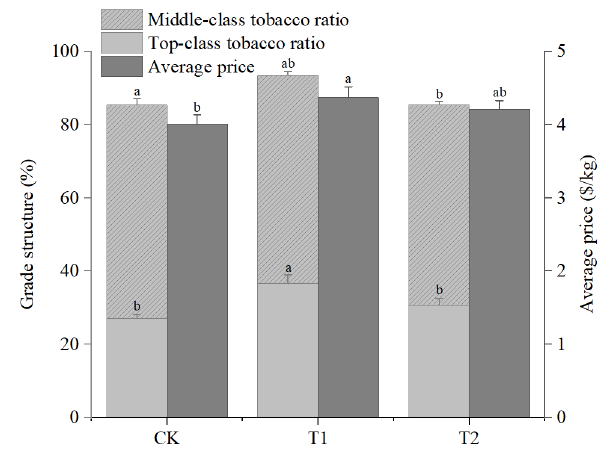
Figure 2. Comparison of economic characteristics of flue-cured tobacco leaves with different treatments.